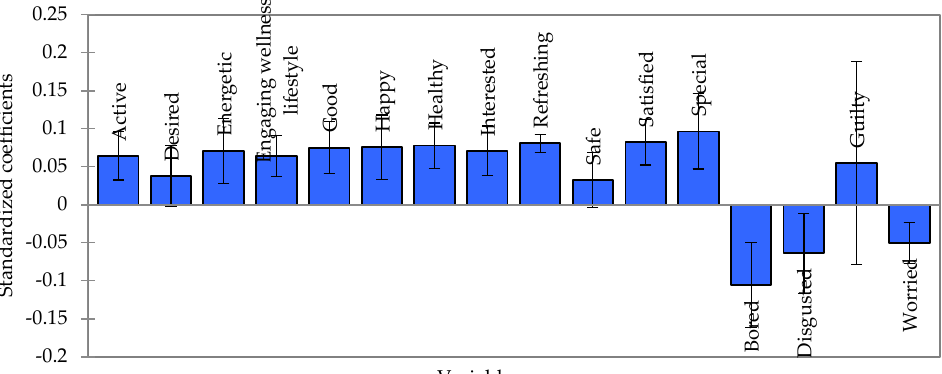
Figure 6. Correlations between emotional attributes evoked by green color cues and the liking of green color based on the partial least squares regression analysis